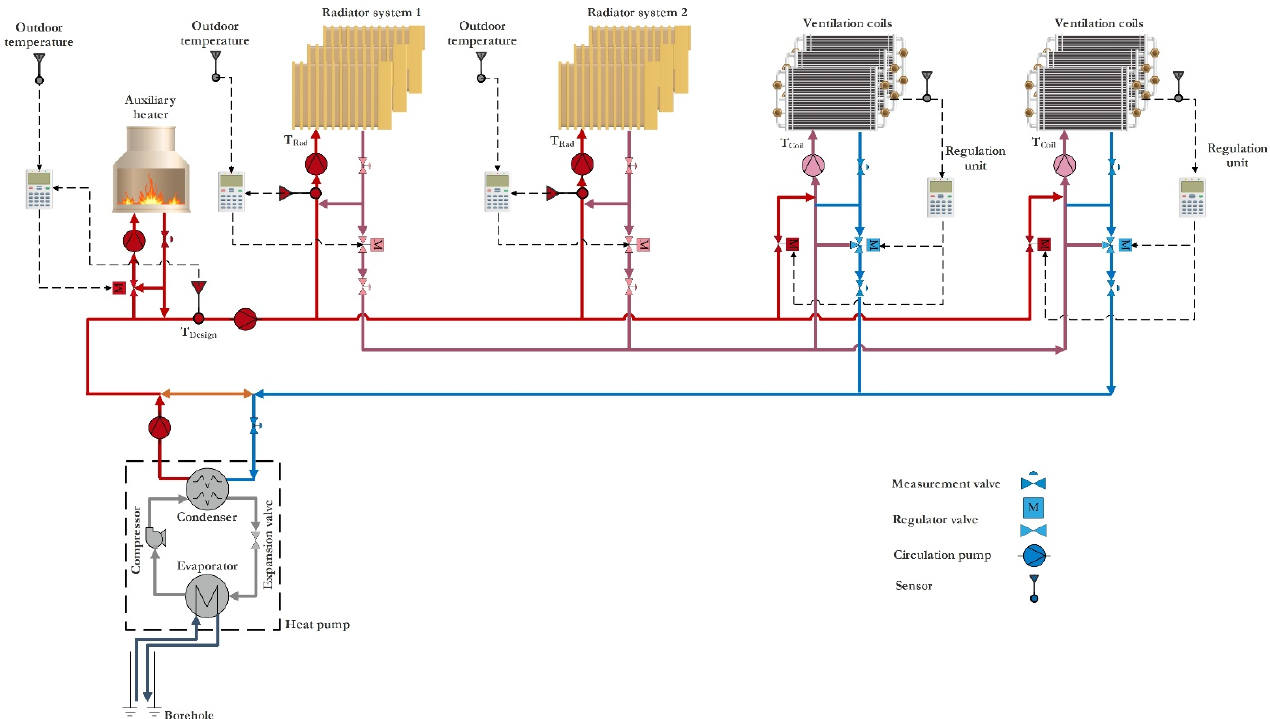
Figure 1. Schematic view of the hydronic heating system installed in the studied hospital including a ground-source heat pump, auxiliary heater, radiators, and ventilation coils.